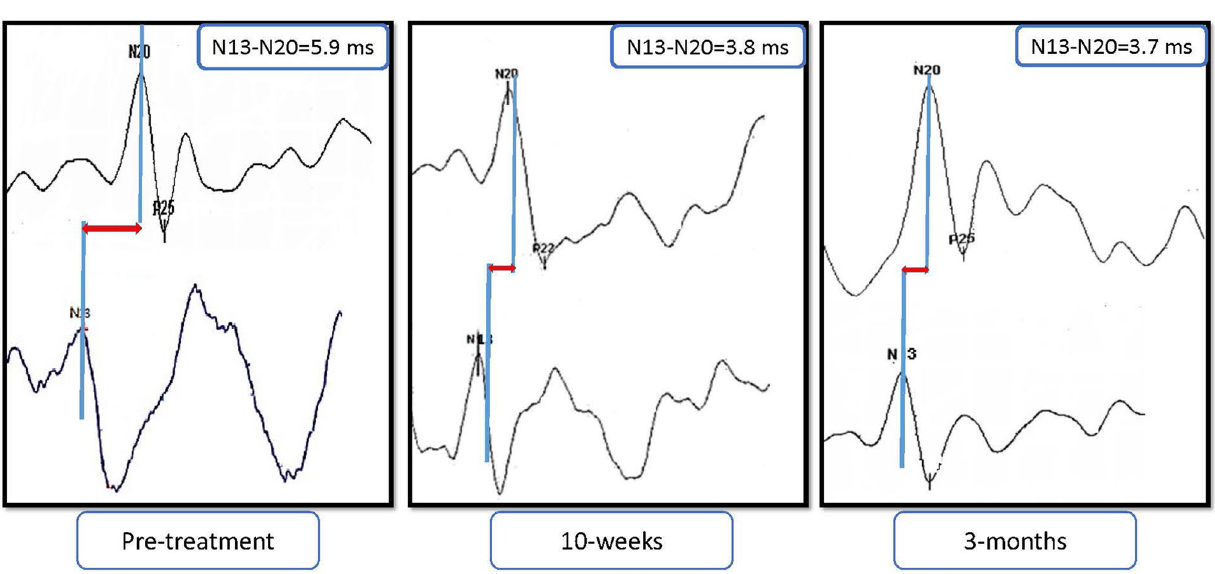
Figure 4. A representative example of central conduction time (N13–N20) at three intervals of measurement: baseline or pre-treatment, following 10-weeks of treatment, and 3-month follow-up. Time is shown in